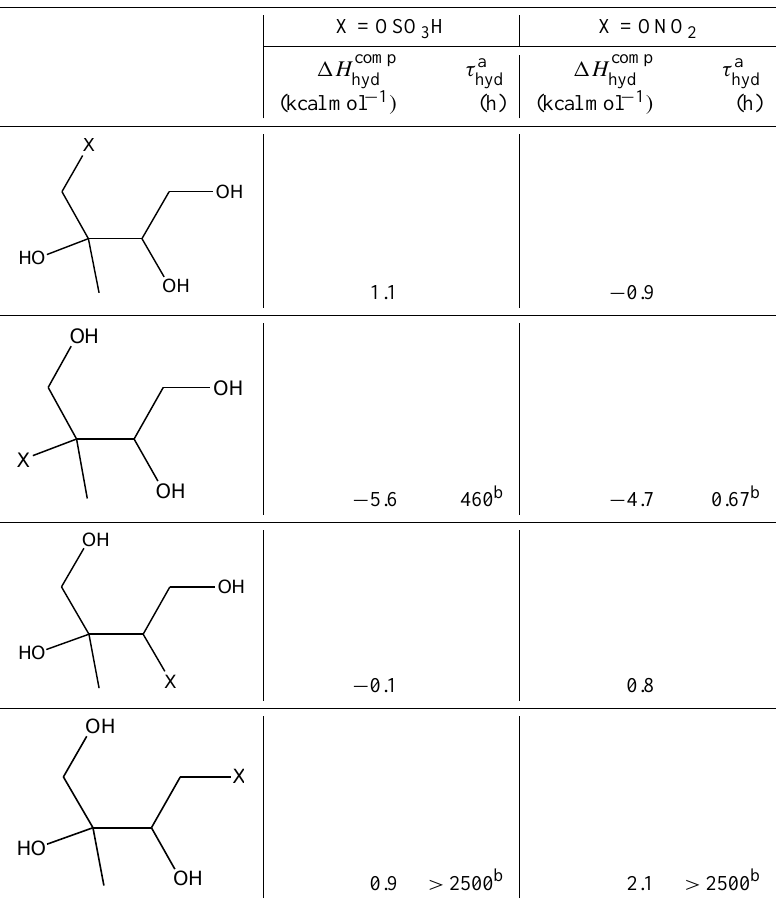
Table 3. Thermodynamic and kinetic parameters for the hydrolysis of isoprene-derived organonitrates and organosulfates.